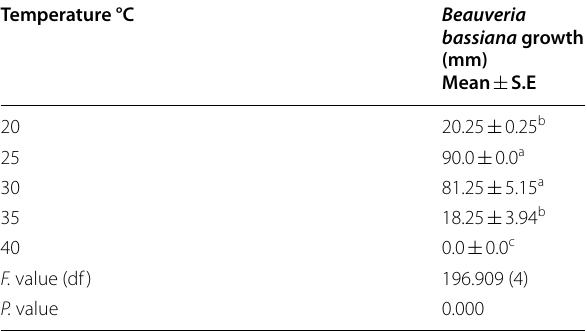
Table 2 Susceptibility of Beauveria bassiana to different temperatures after 4 days